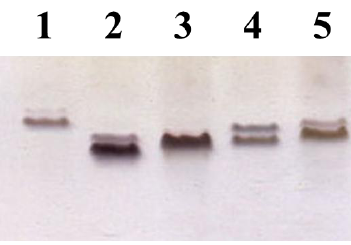
Figure 4. LPS electrophoretic pattern in Tricine-SDS-PAGE. LPS samples isolated from K. pneumoniae 52145 wild type (Lane 1), K. pneumoniae 52145∆ wabG (Lane 2), K. pneumoniae 52145∆ wabG plus pBAD18-Cm- eptC (Lane 3), K. pneumoniae 52145∆ wabH